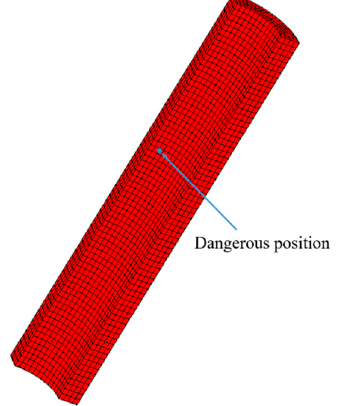
Figure 6. Temperature and stress curve of dangerous position of shot sleeve: ( a ) temperature; ( b ) Von Mises stress.